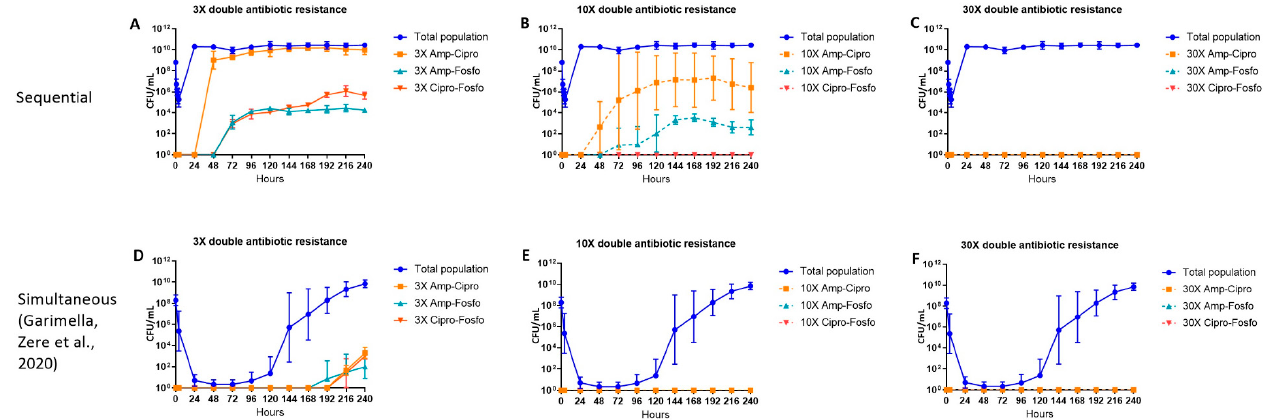
Figure 3. The effect of ampicillin, ciprofloxacin and fosfomycin sequential ( A – C ) and simultaneous combination ( D – F ) [23] therapy regimens on the density of the total and double antibiotic-resistant subpopulations in the hollow fiber infection model over 10 days. The 3×, 10× and 30× double antibiotic-resistant subpopula- tions (Amp-Cipro, Amp-Fosfo and Cipro-Fosfo) were grown on agar containing the respective combinations of antibiotic minimum inhibitory concentration (MIC) levels. Data are presented as the geometric mean of three (sequential regimen) and four (simultaneous combination regimen) independent hollow fiber runs, and the error bars represent the geometric standard deviation